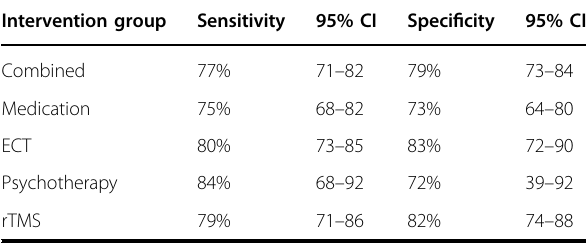
Table 2 Summary estimates of sensitivity/speci fi city for different interventions.